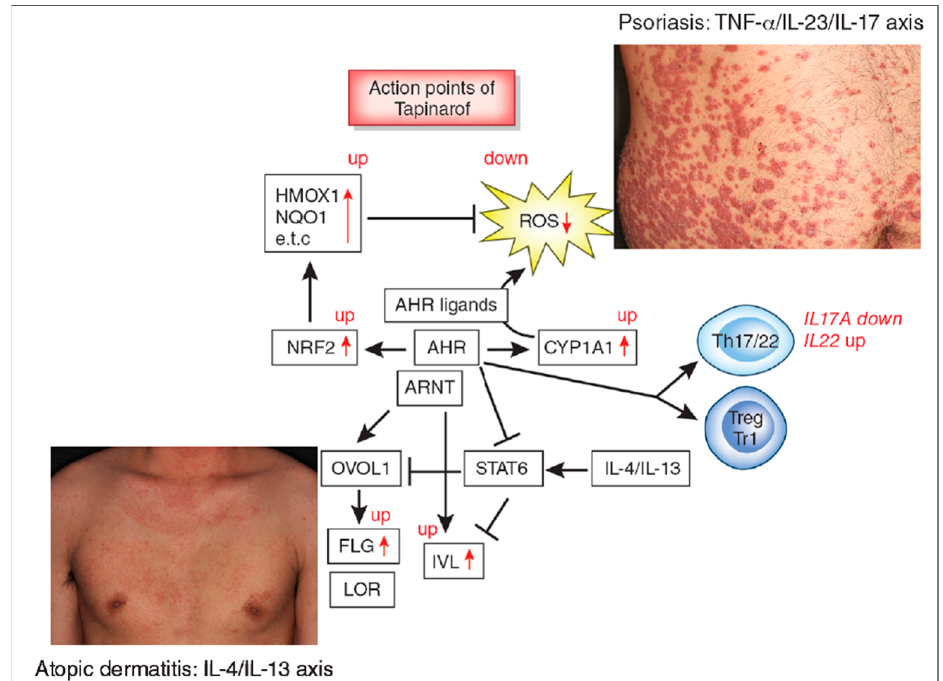
Figure 1. Aryl hydrocarbon receptor (AHR) signal and action points of tapinarof (red words and arrows). AHR is a promiscuous chemical sensor that is activated by various oxidative and